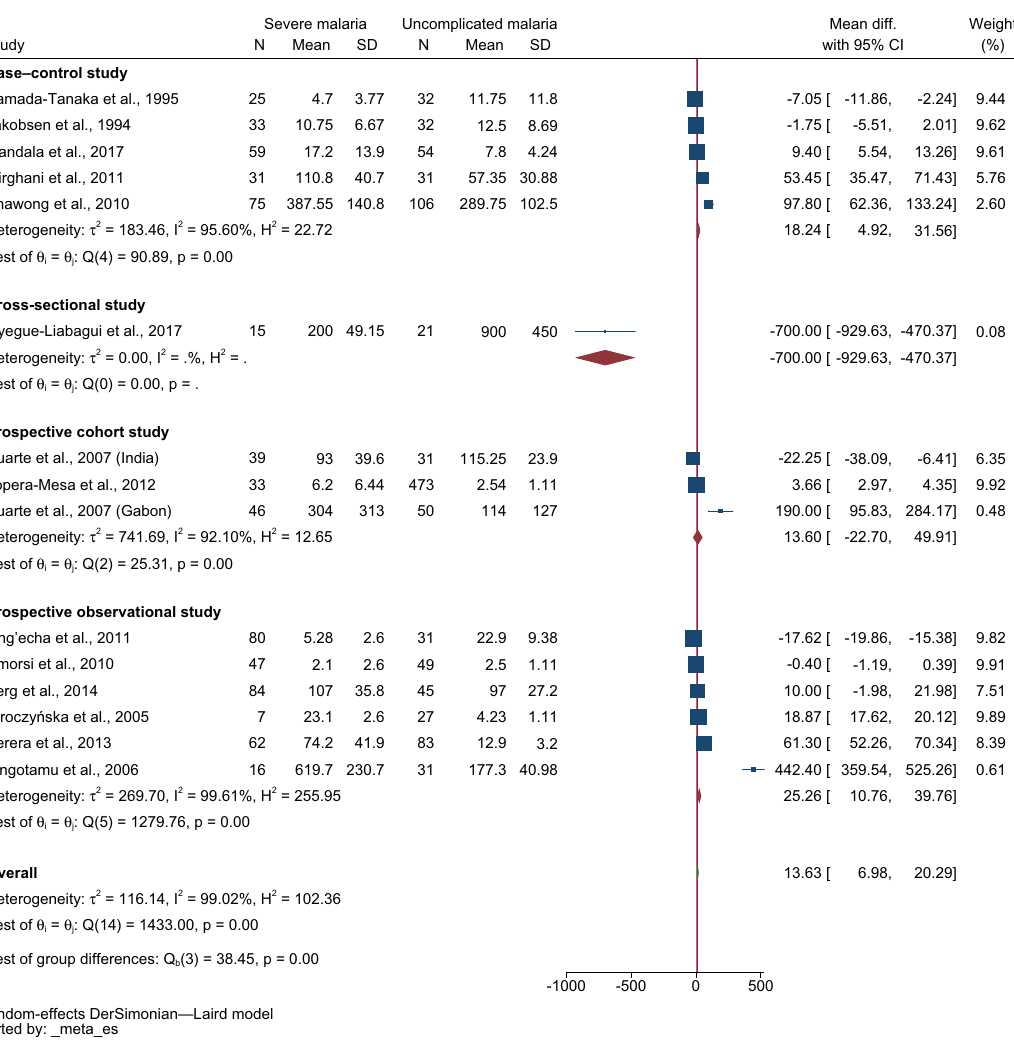
Figure 3. Forest plot demonstrating the pooled MD of INF-γ levels between patients with severe and uncomplicated malaria stratified by study design . CI confidence interval, SD standard